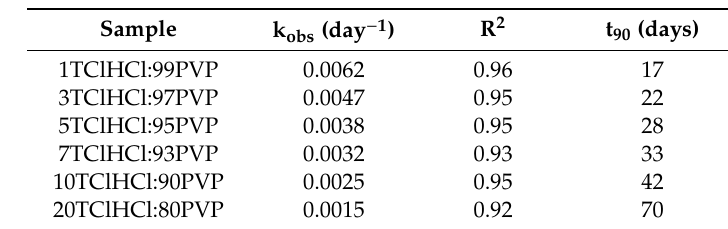
Table 1. Rate constants and t 90 values of thiamine degradation in solid dispersions prepared with di ff erent proportions of PVP, upon storage at 11% RH and 60 ◦